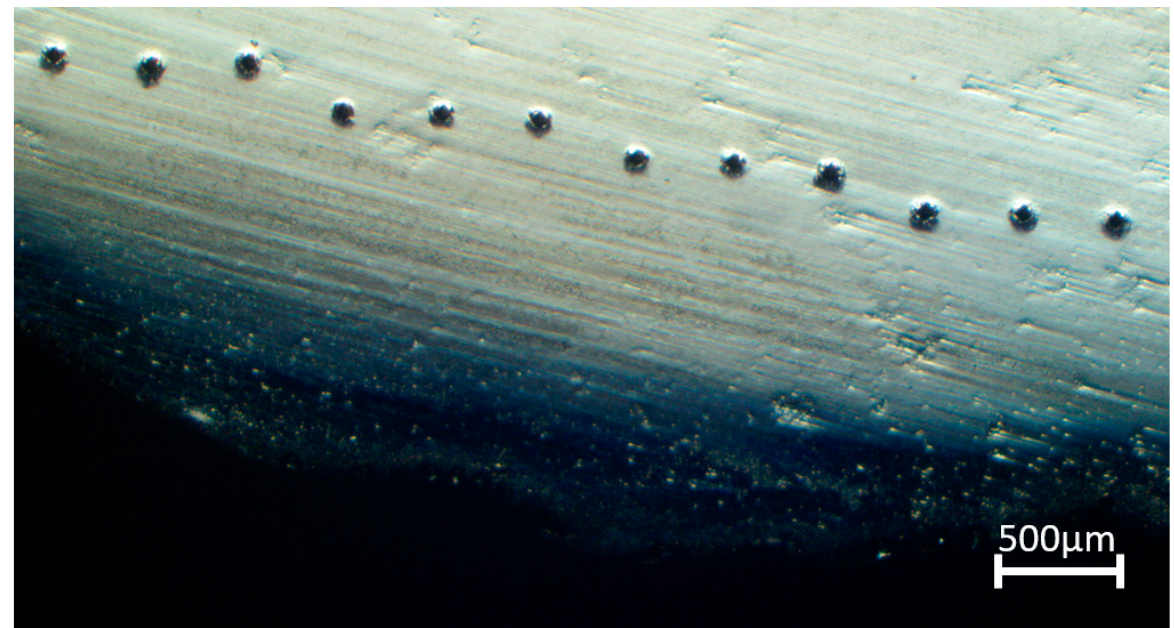
Figure 3. Representative image of indentations used for the hardness measurements.